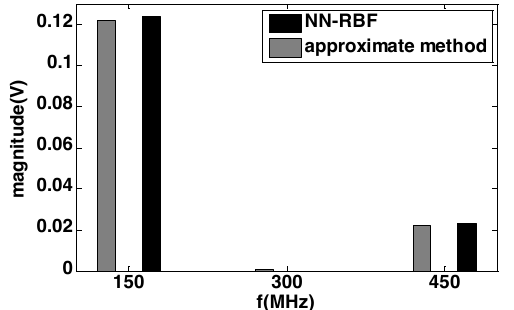
FIGURE 4. Magnitude of induced voltage across the Gun diode based on the NN-RBF [22] and the approximate method in this